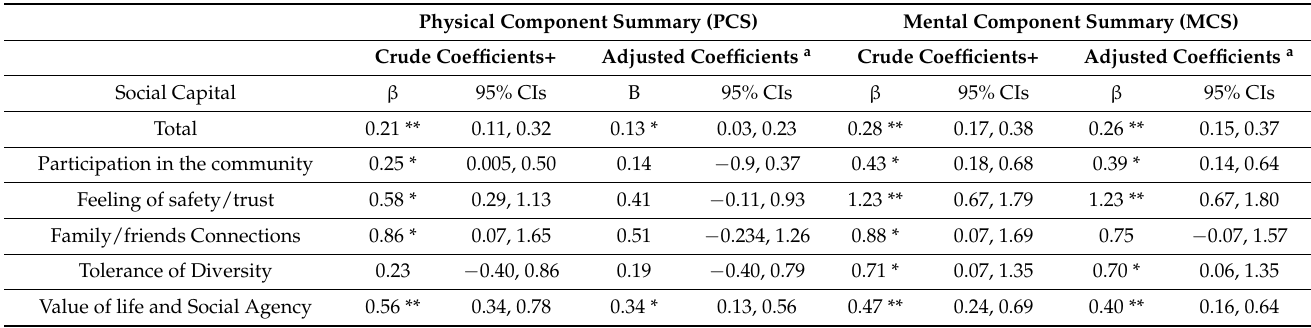
Table 4. Relationships of Social Capital on Physical Component Summary and Mental Component Summary (SF36), in older adults, aged 65+ years, MINOA study, Crete, Greece ( n = 436); multivariable linear regression